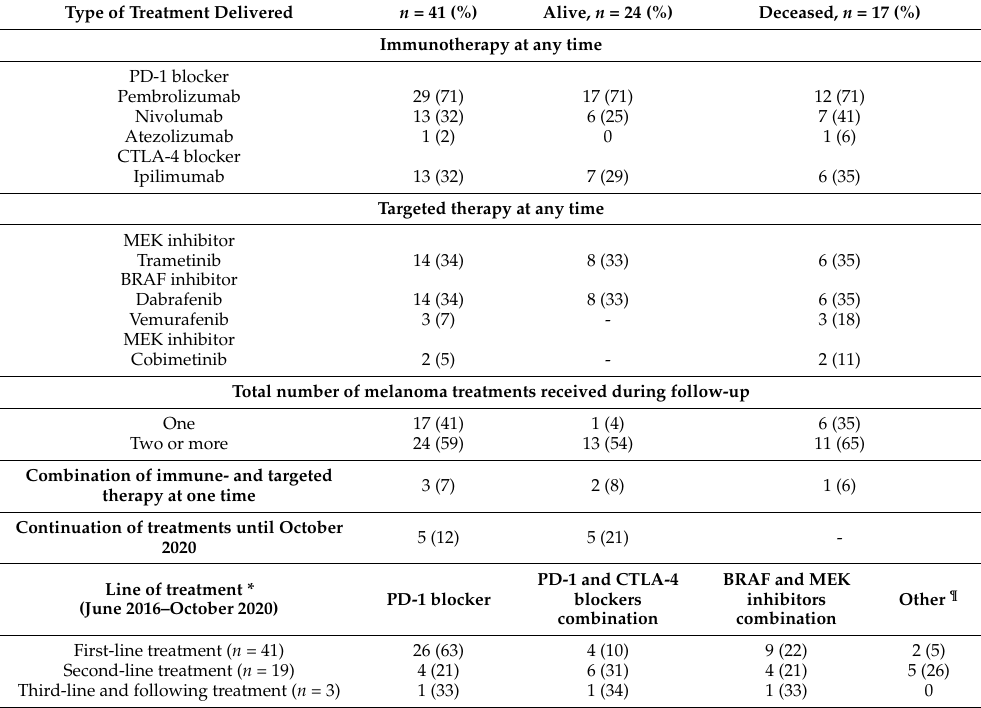
Table 2. Immunotherapy and/or targeted therapy delivered to the participants with advanced melanoma at any time throughout follow-up. Percentages do not add up to 100 as participants could receive multiple treatments over the follow-up